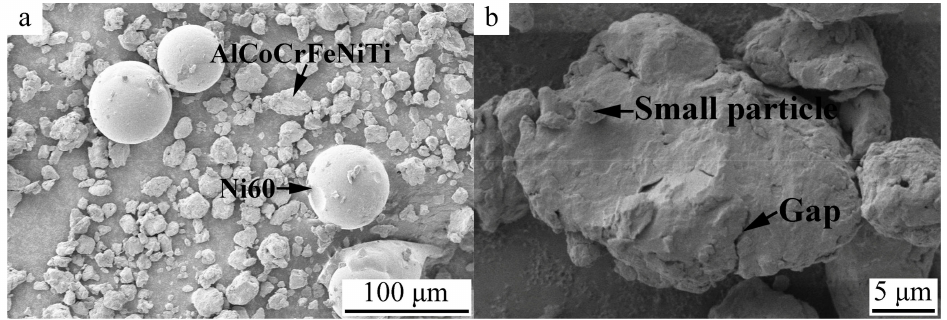
Figure 2. Surface morphology of feedstock: ( a ) mechanically blended HEA/Ni60 powder and ( b ) HEA powder at a higher